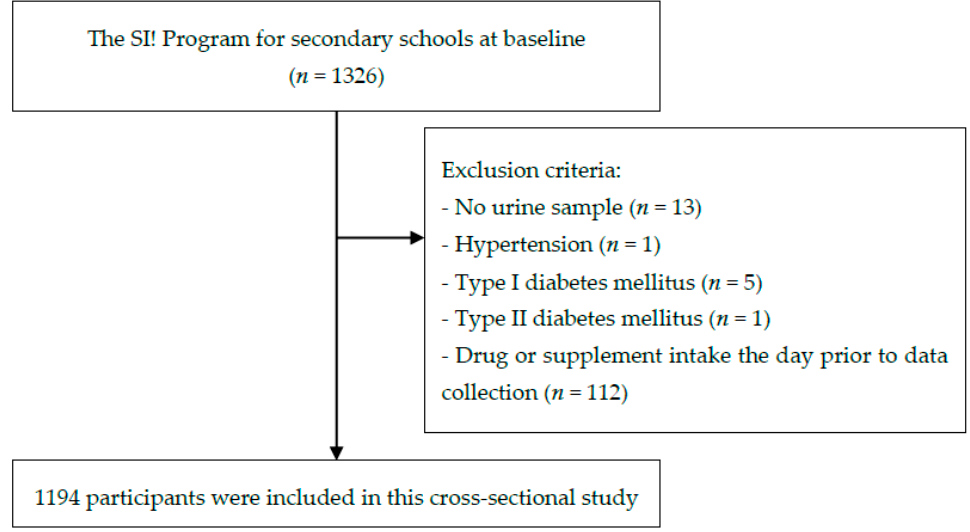
Figure 1. Flow chart of participant selection.